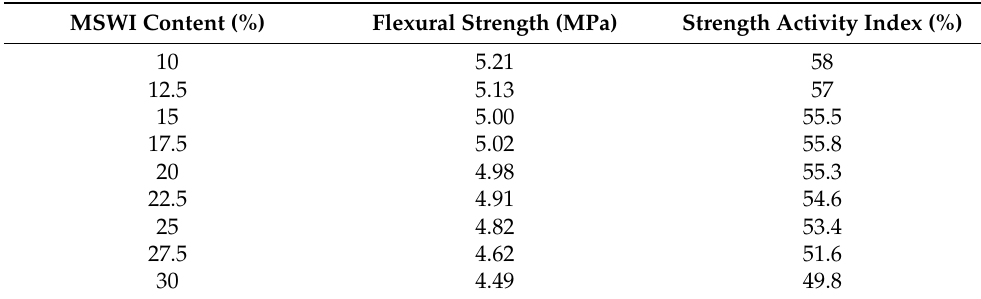
Table 6. Flexural strength of MSWI recycled mortar.